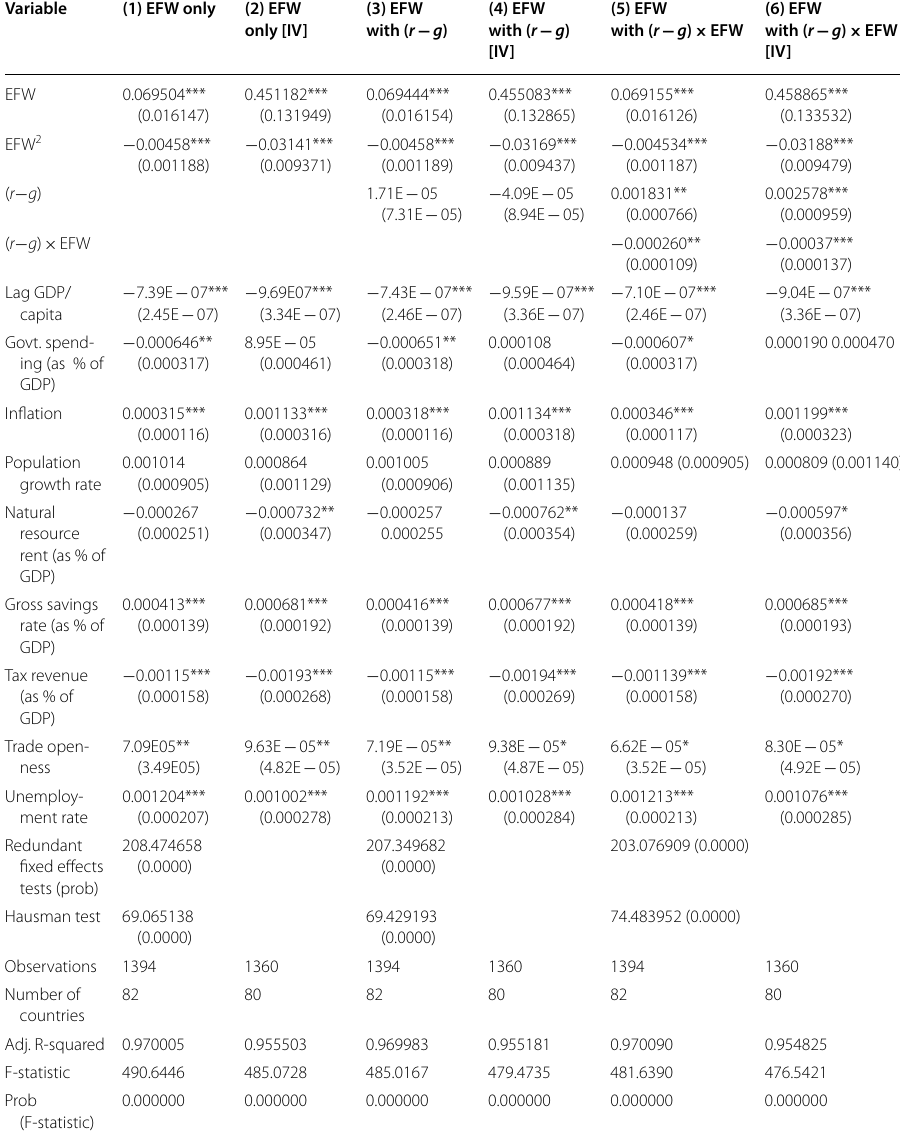
Table 3 Estimation results for global